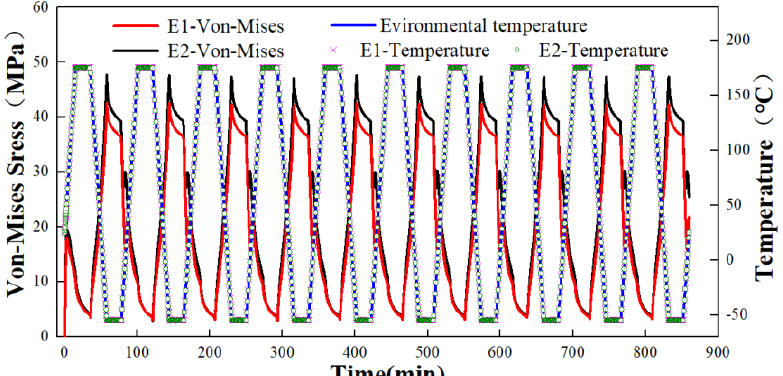
Figure 8: Mises stress time history of the elements E1 and